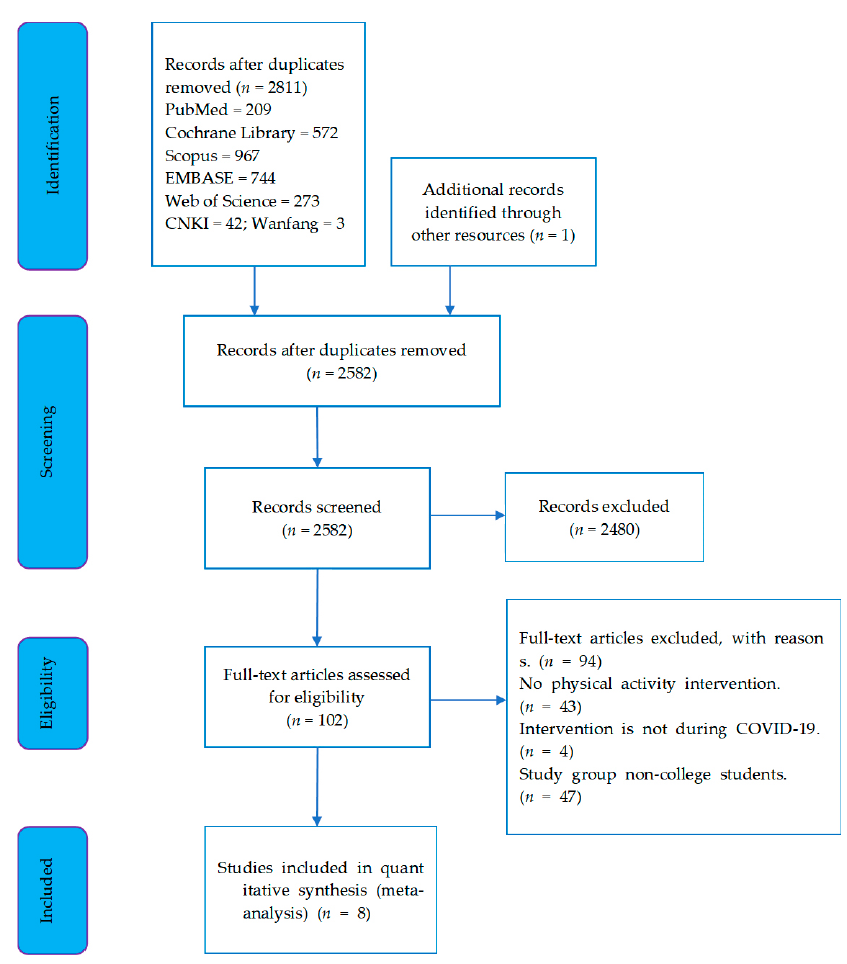
Figure 1. Flow of study